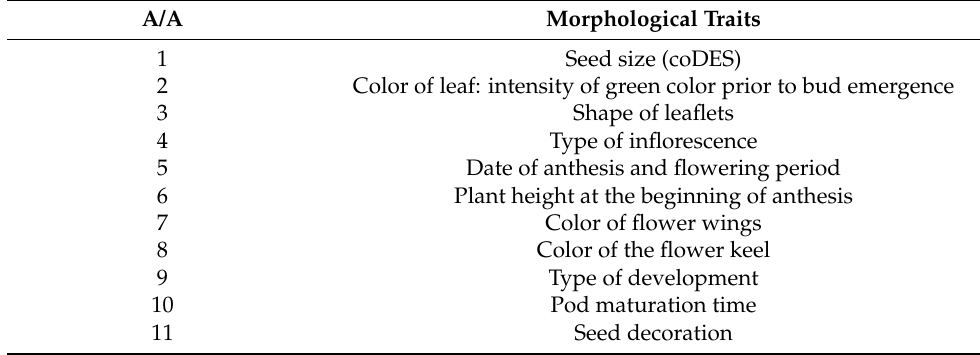
Table 2. Morphological traits estimated according to UPOV guidelines. A/A Morphological Traits Color of leaf: intensity of green color prior to bud